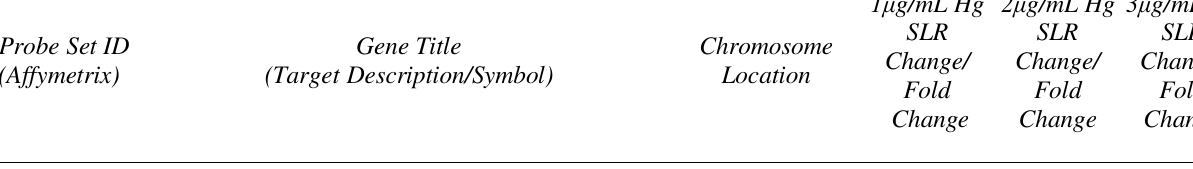
Table 1 contd. : Sample genes affected by